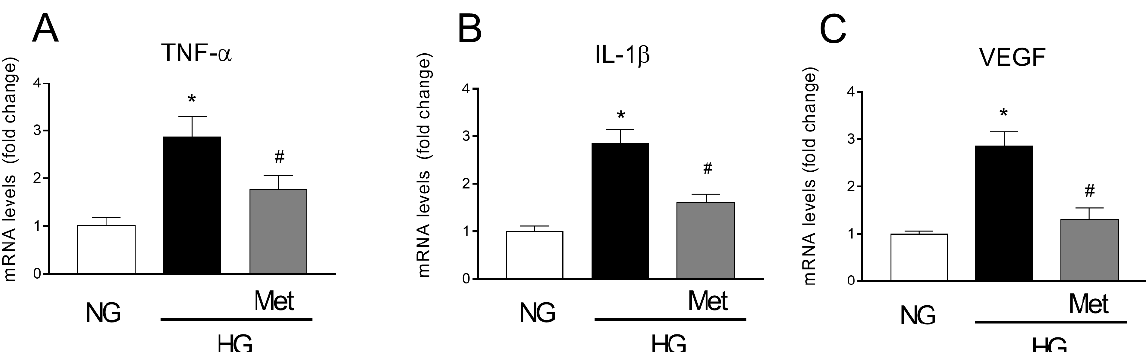
Figure 6. The effects of metoprolol on the pro-inflammatory cytokines and VEGF-A factors in HREC that was stimulated with HG. The cells were cultured in NG (5 mM) or in HG (25 mM) alone or supplemented with metoprolol (Met, 10 μM), epinephrine (Epi, 1 μM), or both compounds. The data were gathered after 48 h from treatment addition. Quantitative analysis of TNF-α ( A ), IL-1β ( B ), and VEGF ( C ) mRNA levels, as evaluated by qRT-PCR. The mRNA levels of each group were normalized to the housekeeping reference gene ribosomal 18S RNA. In the histograms, the values are expressed as fold change of those that were detected in HREC that was cultured in NG condition. Each value represents the mean ± SD that was obtained from three independent experiments with four parallel samples for group in each experiment. * p < 0.05 vs. NG; # p < 0.05 vs. HG. The non-parametric Mann-Whitney test was used for pairwise comparisons.